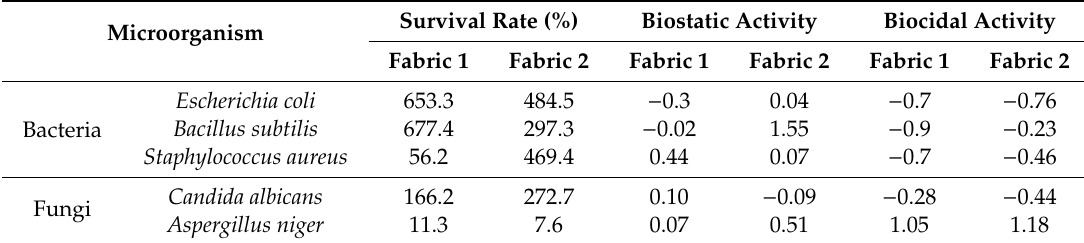
Table 6. Antimicrobial activity of beeswax-modified